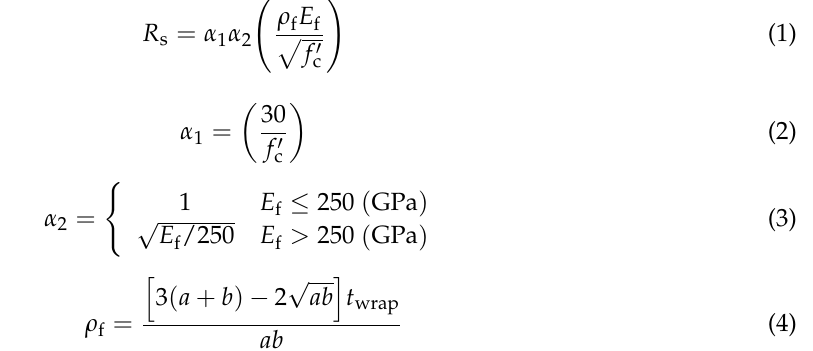
where k ε is a factor that considers the reduction in measured FRP hoop